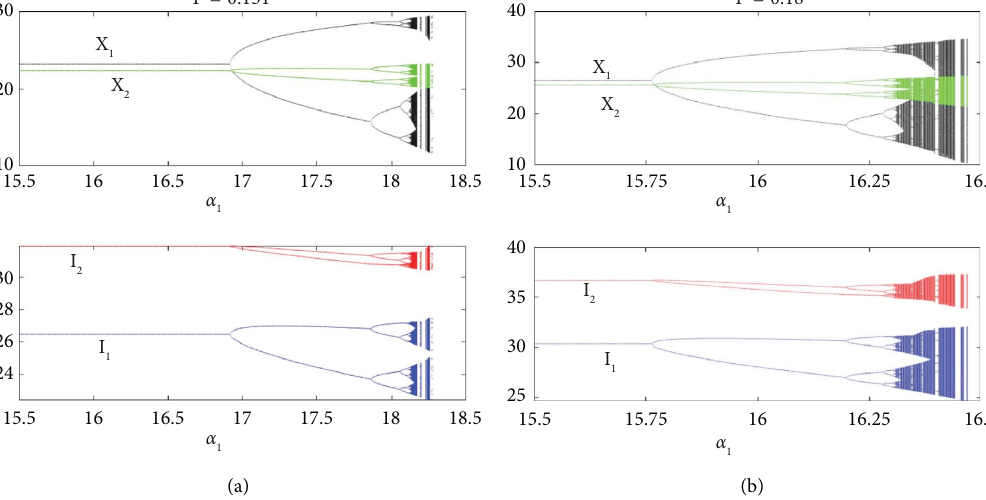
of R&D investment under the market 1